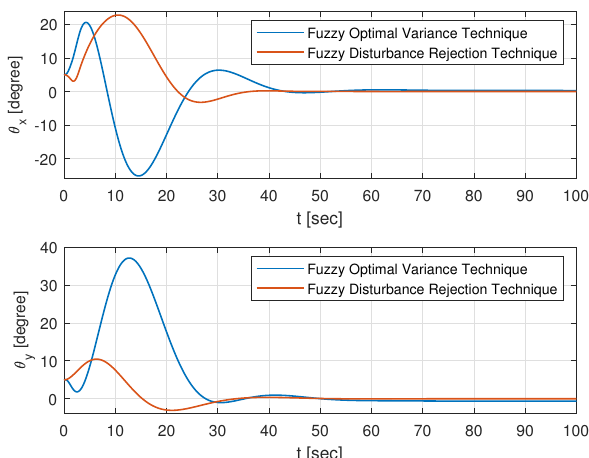
Figure 24. Angular position of the